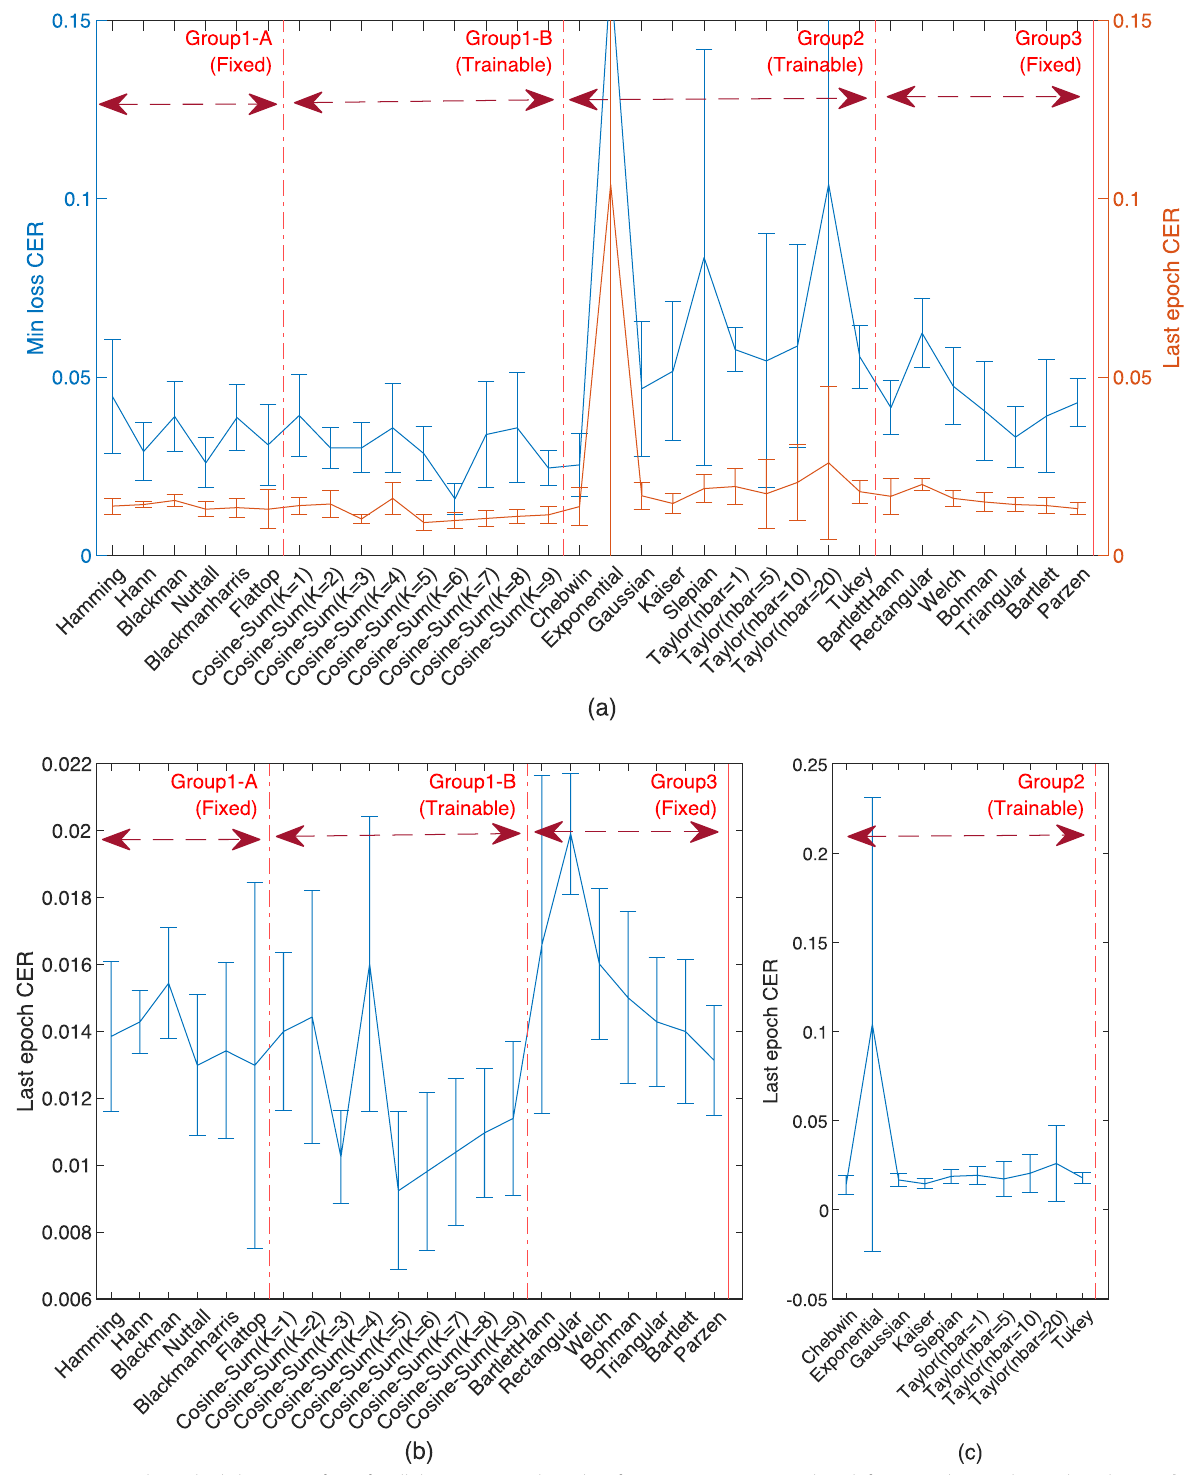
Fig. 5 Mean and standard-deviation of CER for all the investigated window functions a at minimum loss (left axis) and at 100th epoch (right axis). b Enlarged view of the CER at 100th epoch for Group1 - A , Group1 - B , and Group3 functions, and c Group2